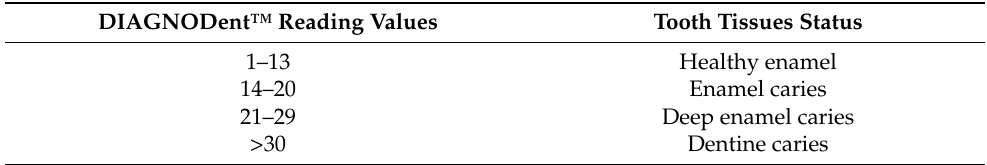
Table 1. The DIAGNODent™ pen readings classification. DIAGNODent™ Reading